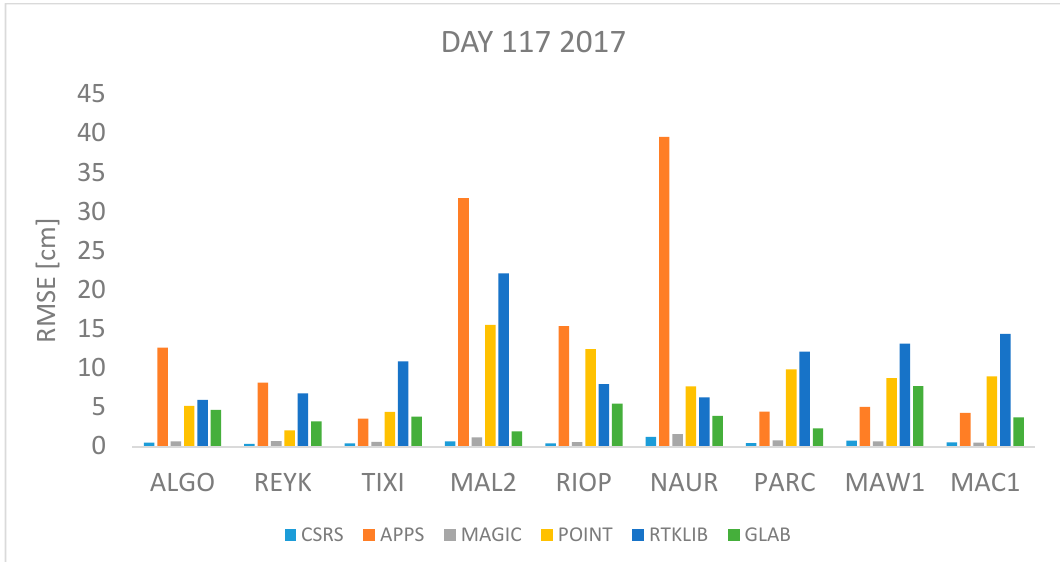
Figure 4. RMSE in centimeters for day 117 2017.